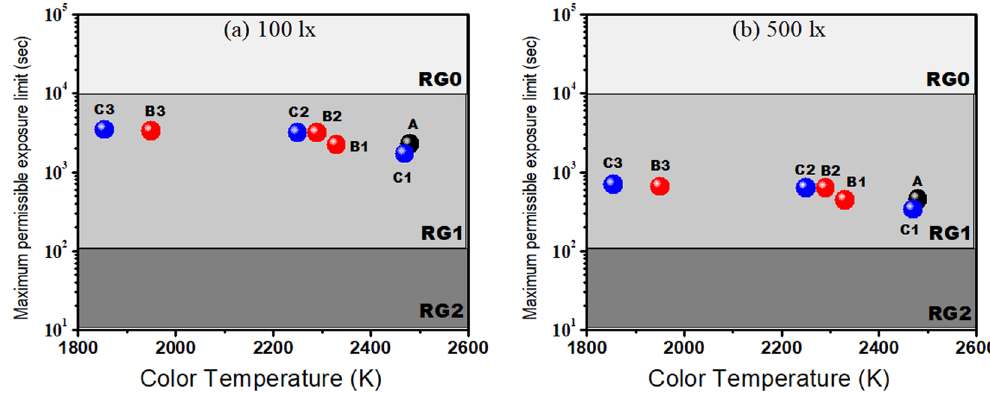
Figure 2. Effect of color temperature of the studied low color temperature OLEDs on the retinal maximum permissible exposure limit at ( a ) 100 and ( b ) 500